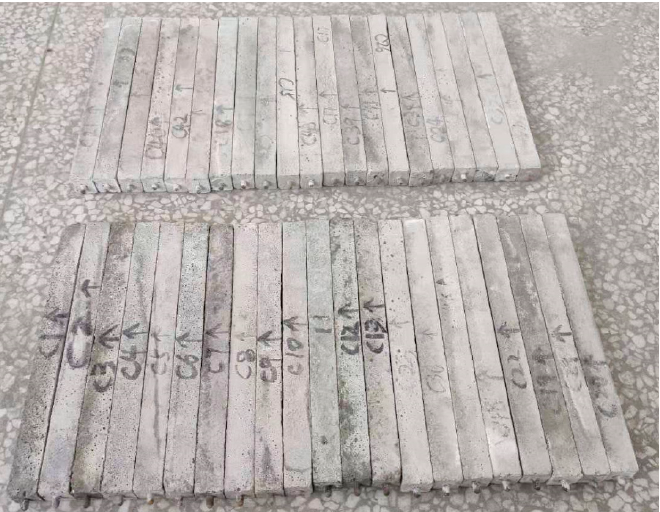
Figure 3. Bar specimens used in ASR expansion test.